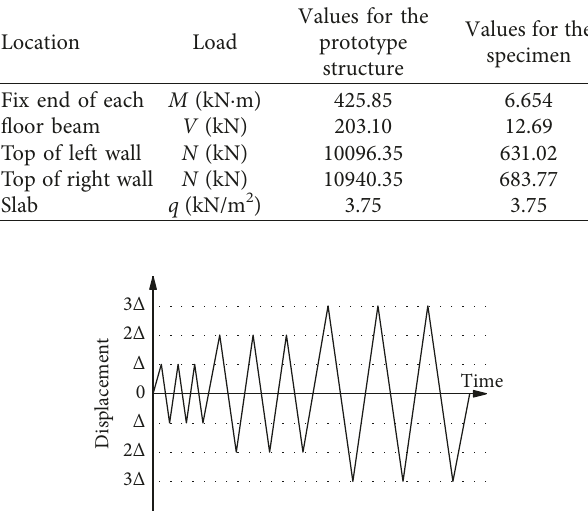
Figure 6: Loading scheme of the cyclic